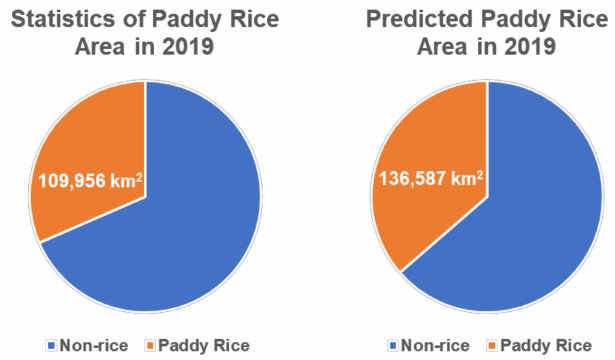
Figure 21. The total area of paddy rice in